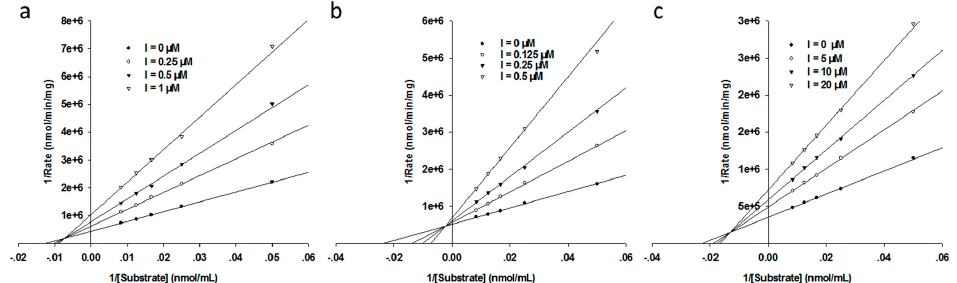
Figure 2. Inhibition curves of DC1 against NDM ‐ 1, IMP ‐ 1, ImiS and L1.